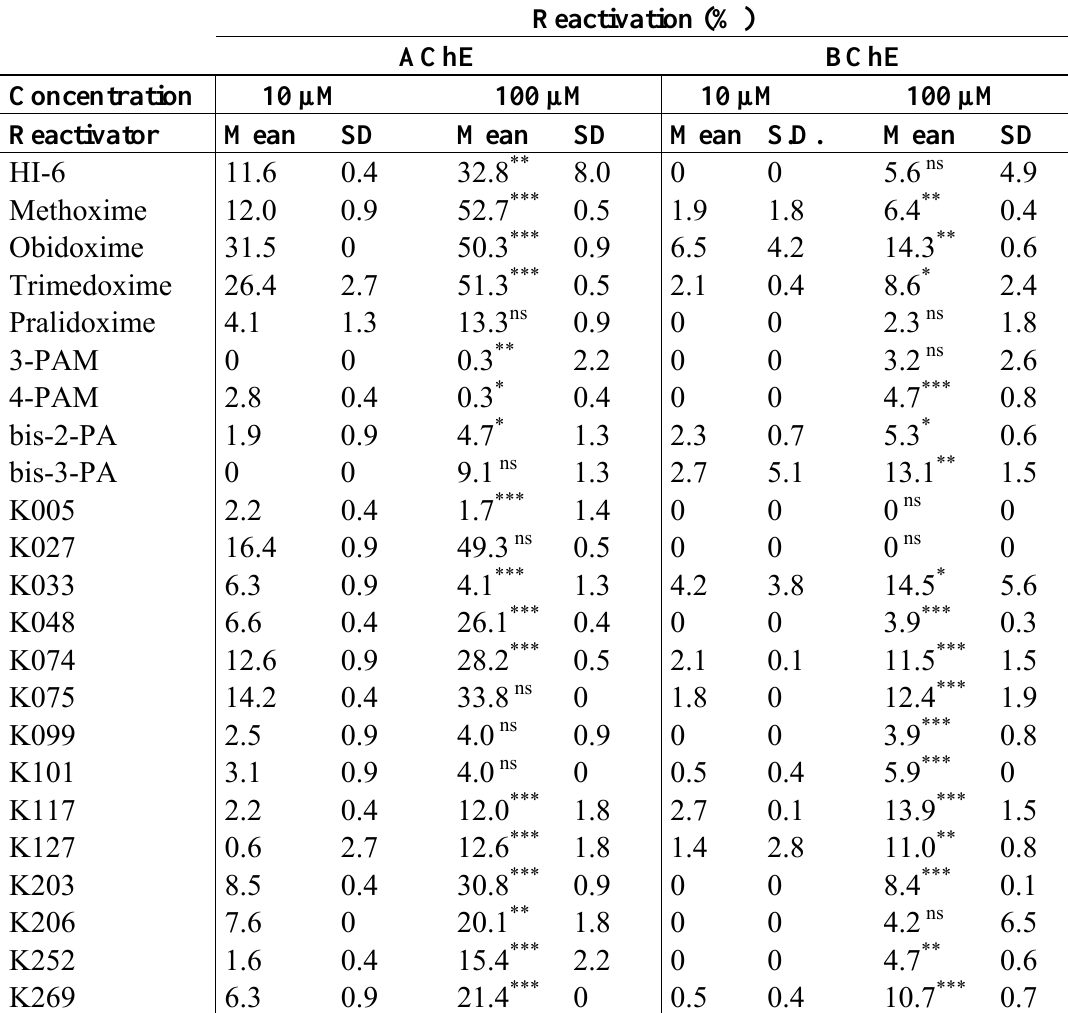
Table 1. Potency of tested oximes to reactivate leptophos-oxon - inhibited human erythrocyte AChE and plasma BChE at concentrations 10 µM and 100 µM. (%, mean value of three independent determinations, time of inhibition by leptophos-oxon 120 min; time of reactivation by AChE reactivators ― 10 min; pH 7.4; temperature 25 °C). * P < 0.05, ** P < 0.01, *** P < 0.001, ns: not significant - compared with potency at 10 µM